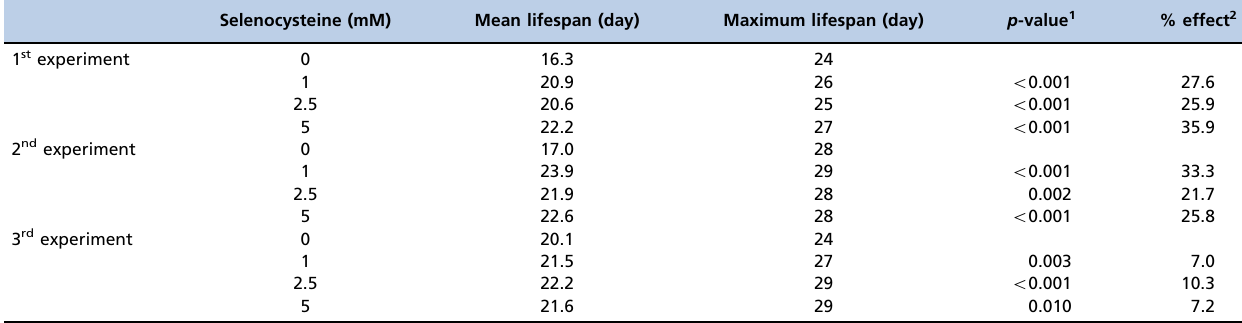
Figure 2 - Effects of selenocysteine on survival after UV irradiation. After 24 h of selenocysteine pre-treatment, animals were irradiated with 20 J/cm 2 /min of UV light for 1 min. The time-course % survival of age-synchronized worms (n=60) was then monitored every day until all worms were dead in the untreated and selenocysteine-treated groups. Mean survival time was significantly increased with 1 or 2.5 mM selenocysteine ( p o 0.05). Table 1 - Effect of selenocysteine on lifespan in C.